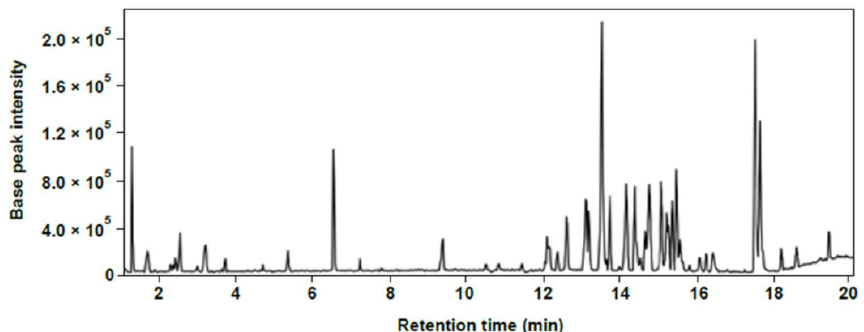
Figure 1. Representative LC-MS total ion current (TIC) chromatograms of methanol extract of Chinese chive in negative ion